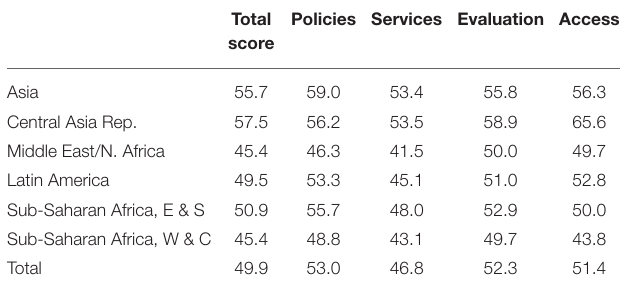
TABLE 2 | Strength of national family planning programs.